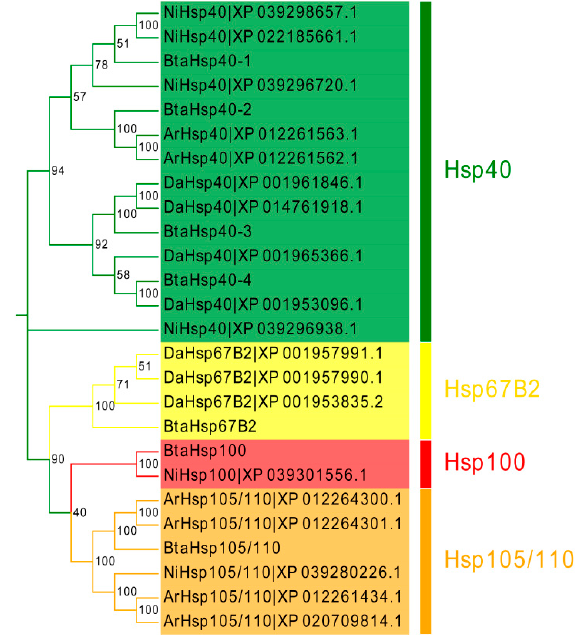
Figure 3. Phylogenetic relationships of Hsp40 , Hsp100 , Hsp105/110 , and Hsp67B2 from Bemisia tabaci , Drosophila ananassae , Athalia rosae , and Nilaparvata lugens . The unrooted phylogenetic tree was constructed using MEGA7 by the neighbor-joining method. The bootstrap test set as 1000 replicates.